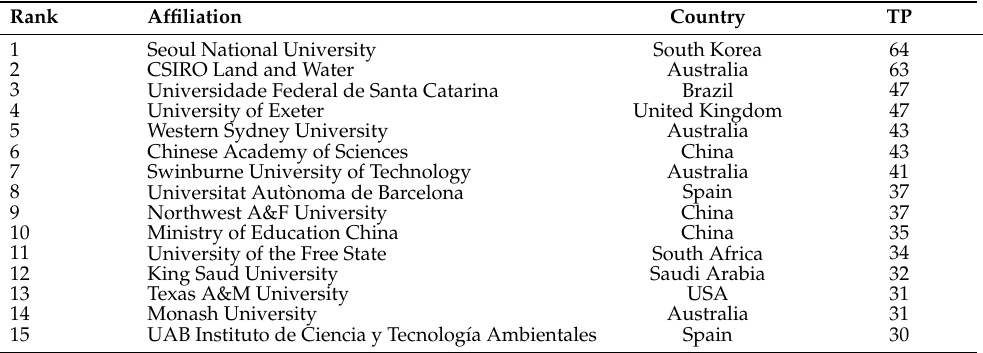
Table 10. The top 15 productive institutions,